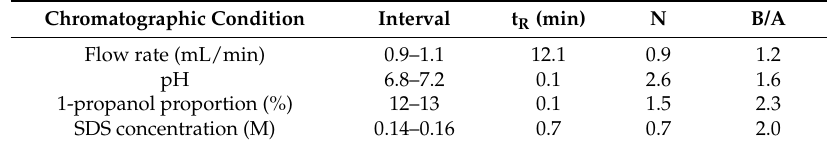
Table 2. Robustness evaluation of the developed micellar liquid chromatography (MLC) method (RSD,